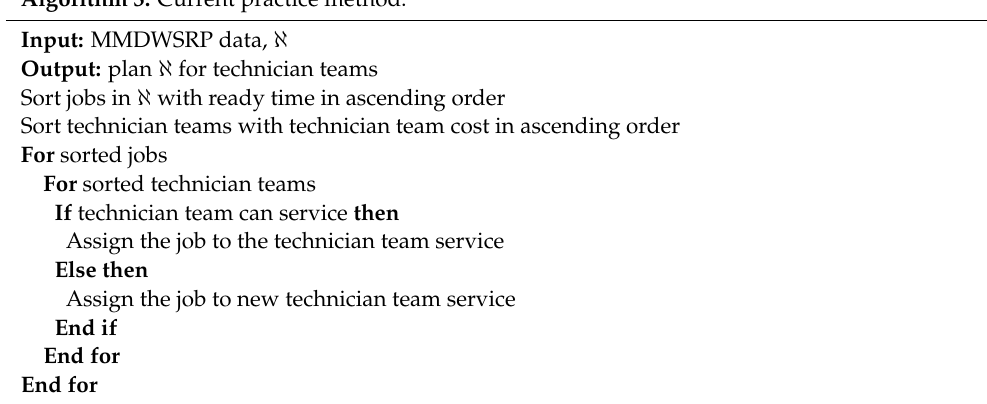
Algorithm 3. Current practice